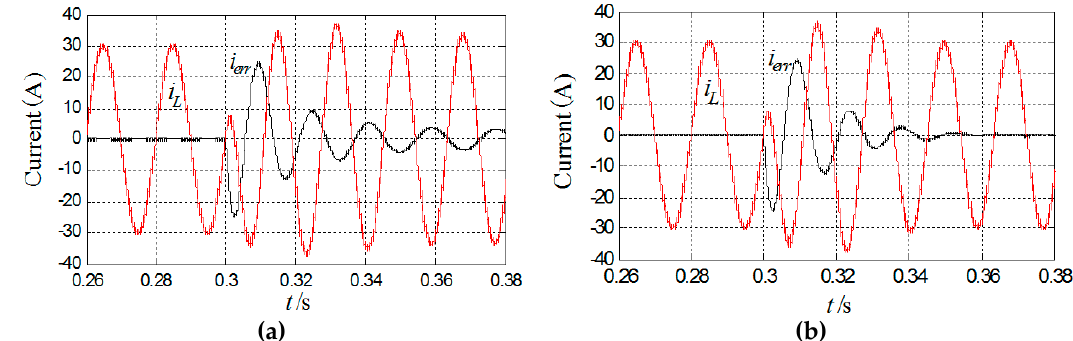
Table 3. Parameters of the experimental prototype Figure 17. Inductor current and tracking error. ( a ) Non-adaptive PIR control. ( b ) FSAPIR control.